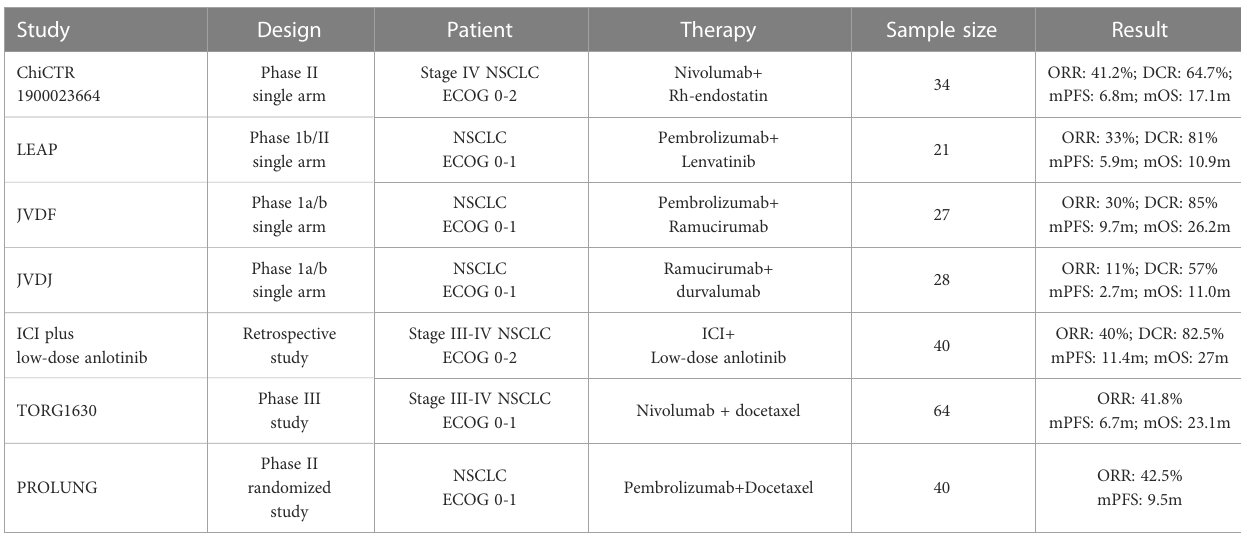
TABLE 6 Comparison of similar clinical studies.